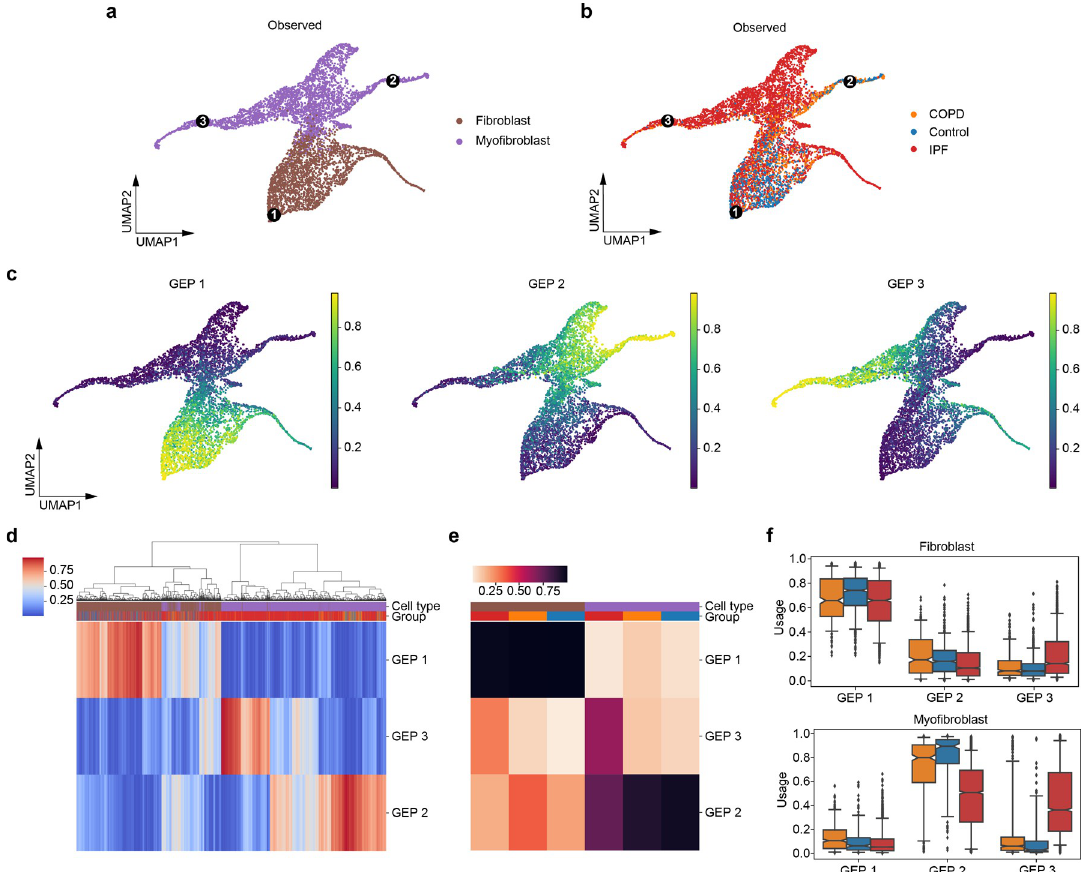
Fig 7. scAAnet identified 3 GEPs in the lung fibroblast and myofibroblast cells. (a) The UMAP visualization (Methods) of observed scRNA-seq data colored by cell types. (b) The UMAP visualization of observed scRNA-seq data colored by disease groups. Black dots in a and b are locations of cells that have the largest usage of the corresponding GEP (marked in Arabic numerals). (c) UMAPs colored by inferred cell usage for each GEP. (d) Heatmap showing the usage of all GEPs (rows) in all cells (columns). Cells are ordered by hierarchical clustering. (e) Heatmap showing the percentage of cells with usage > 25% of each GEP (rows) in each cell type and disease group (columns). Colors of cell types and disease groups in d and e are coded in the same way as colors in a and b. (f) Box and whisker plot of the usage of each GEP in cells of fibroblast (top) and myofibroblast (bottom), colored by disease groups (colors are coded in the same way as in b). Central lines represent medians, boxes represent the IQR, and whiskers represent the 5th and 95th quantiles. biological processes (Fig 8A and S14 Table) among which the top one with the smallest p-value is